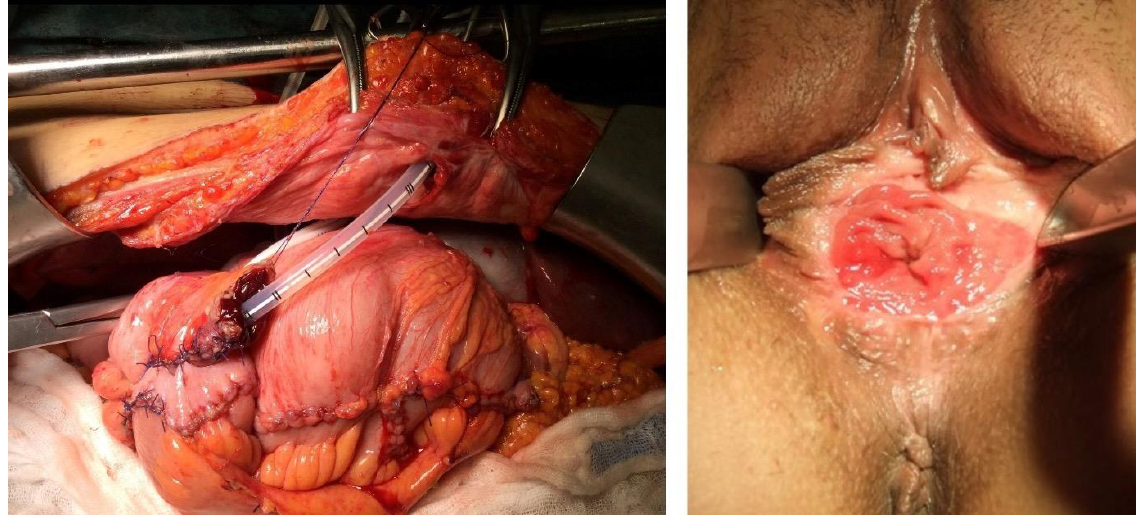
Figure 3. Reconstructed continent urinary reservoir by ileo-cecal segments with catheterizable outlet before anastomosis to the umbilicus (surgeons: S. Roth and B. Lampe) and formation of a neovagina—uses a section of the sigmoid colon (surgeon: B. Lampe).